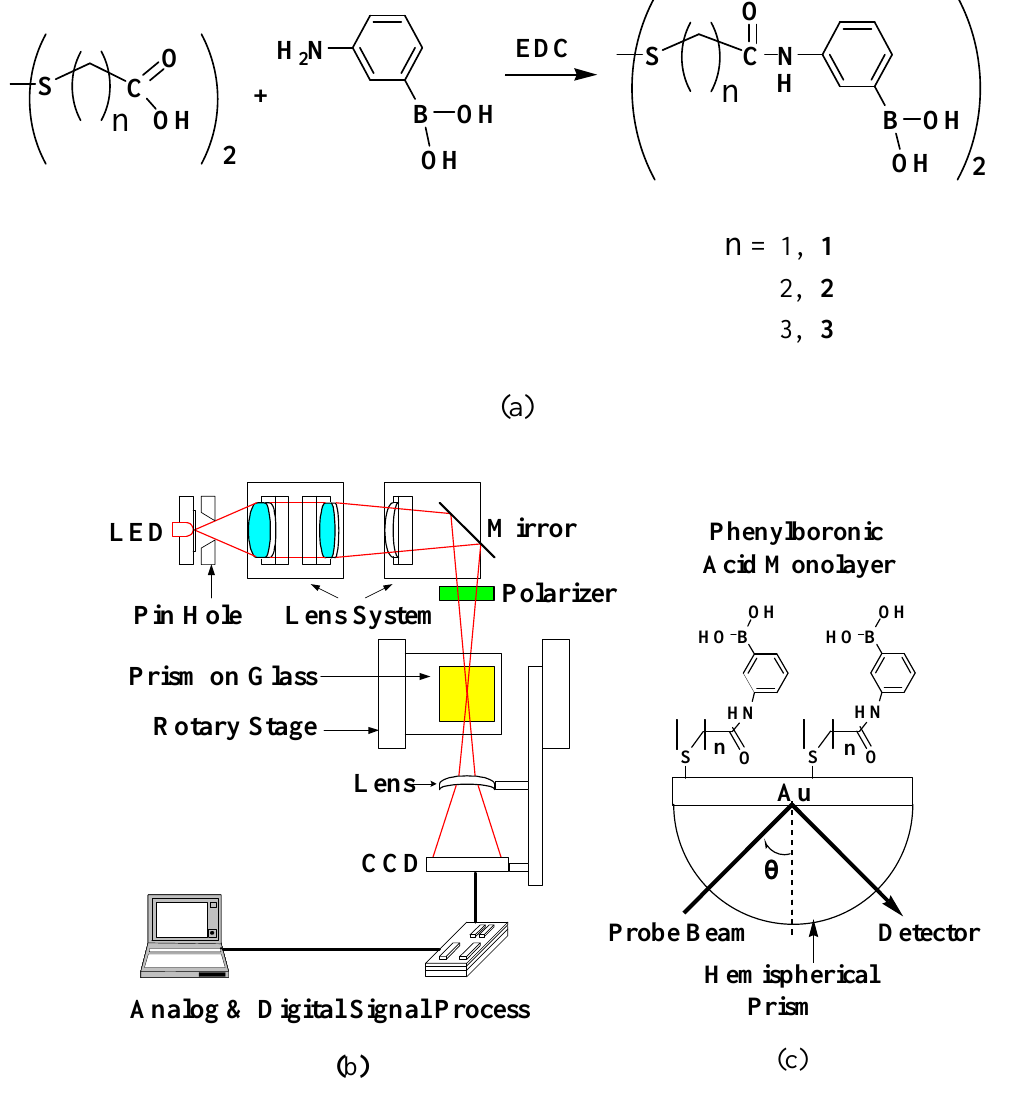
Figure 1. Scheme of (a) synthesis of phenylboronic acid derivatives (n = 1, 2, 3); (b) the SPR system and (c) the sensor chip